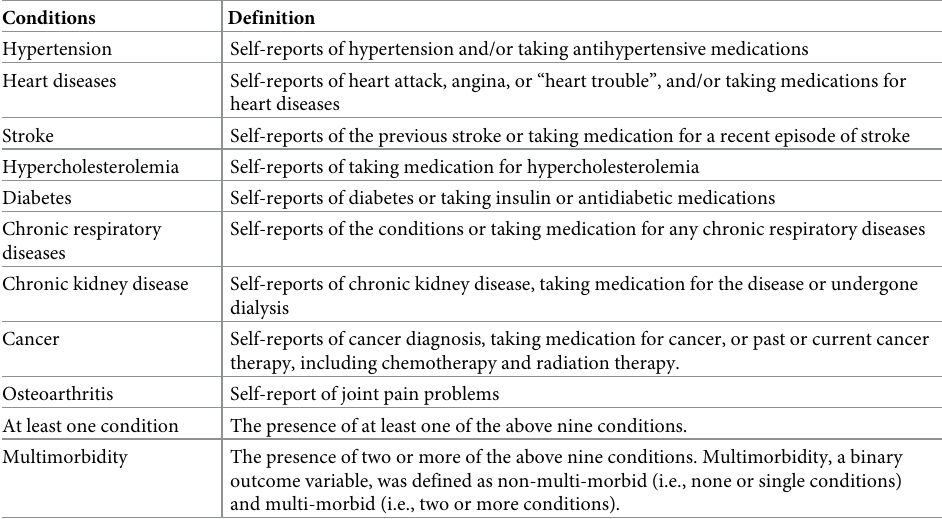
Table 1. Definition of a single condition and